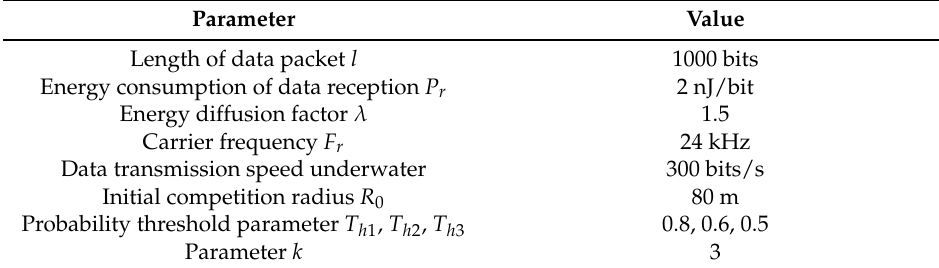
Table 1. Simulation parameters.